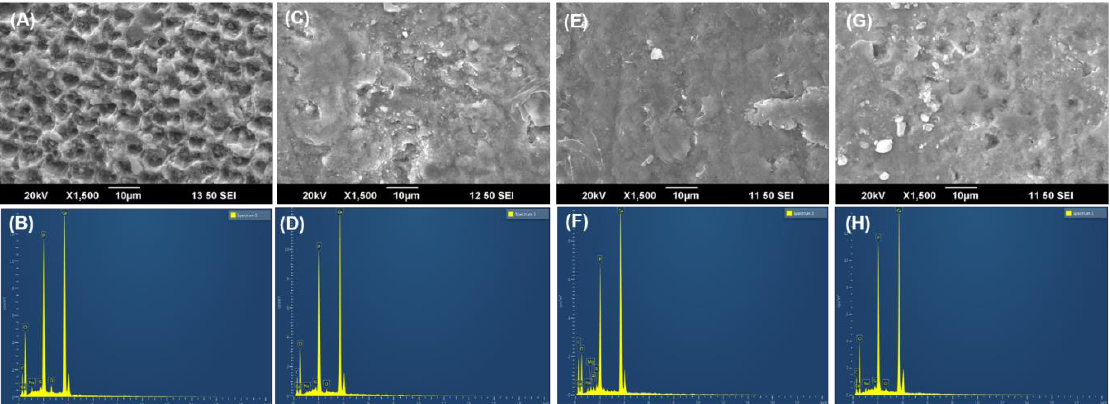
Figure 11. SEM ( A , C , E , G ) and EDX ( B , D , F , H ) analysis of the enamel images are the SEM images of the demineralized enamel specimen, GC tooth mousse applied enamel, alkali-treated nano HA applied enamel, and thermally calcined nano HA applied enamel,